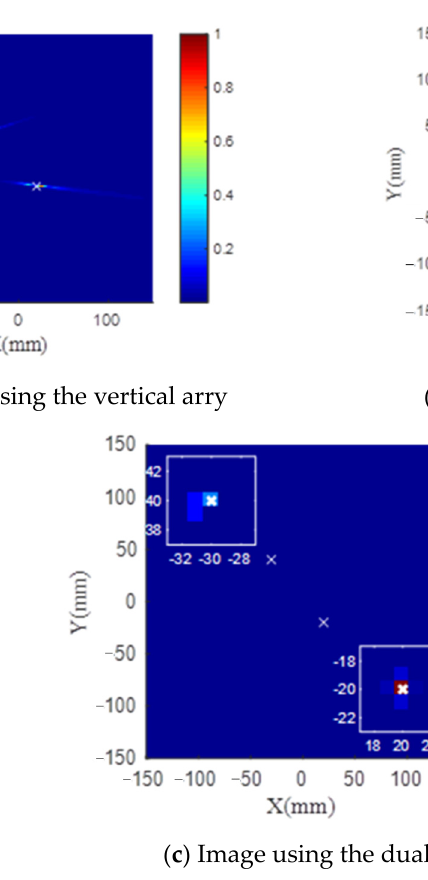
Figure 15. Comparisons of damage image between single and dual